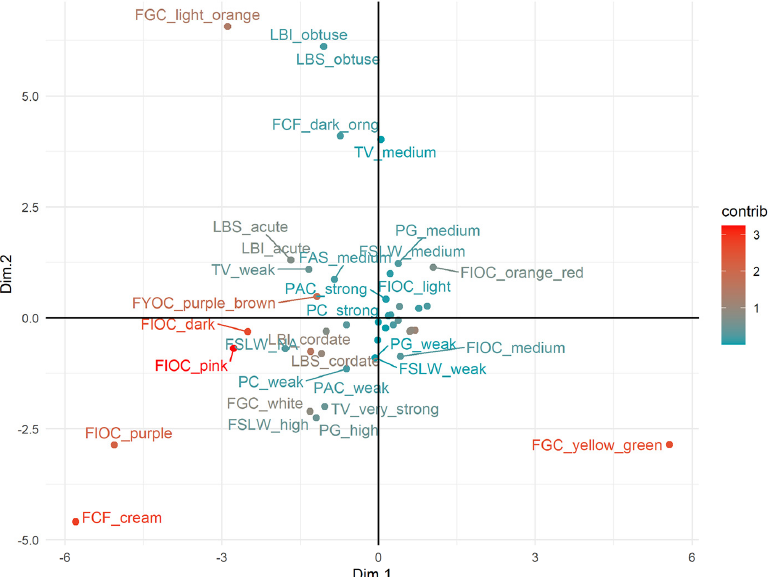
Figure 7. Distribution of the qualitative phenotypes (categories of the qualitatively scored traits) in the bidimensional factorial plain. For graphical reasons, the label of18 phenotypes in the central area is omitted. Phenotypes are colored according to their relative contribution to the principal dimensions following the scale bar reported on the right-hand side of the plot. Variable code names and phenotypes are reported in Table